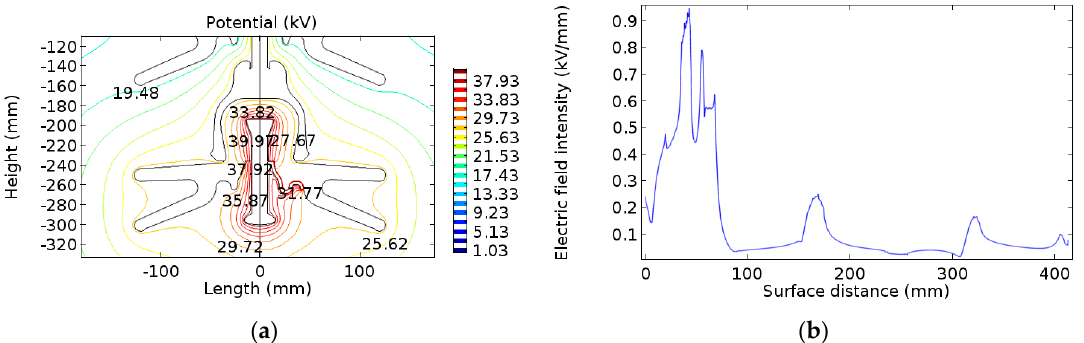
Figure 18. Simulation results of Extension 3: ( a ) equipotential line distribution; ( b ) electric field distribution along No. 1 insulator.